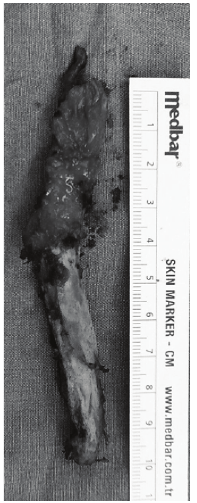
Figure 3: Photo of the excised